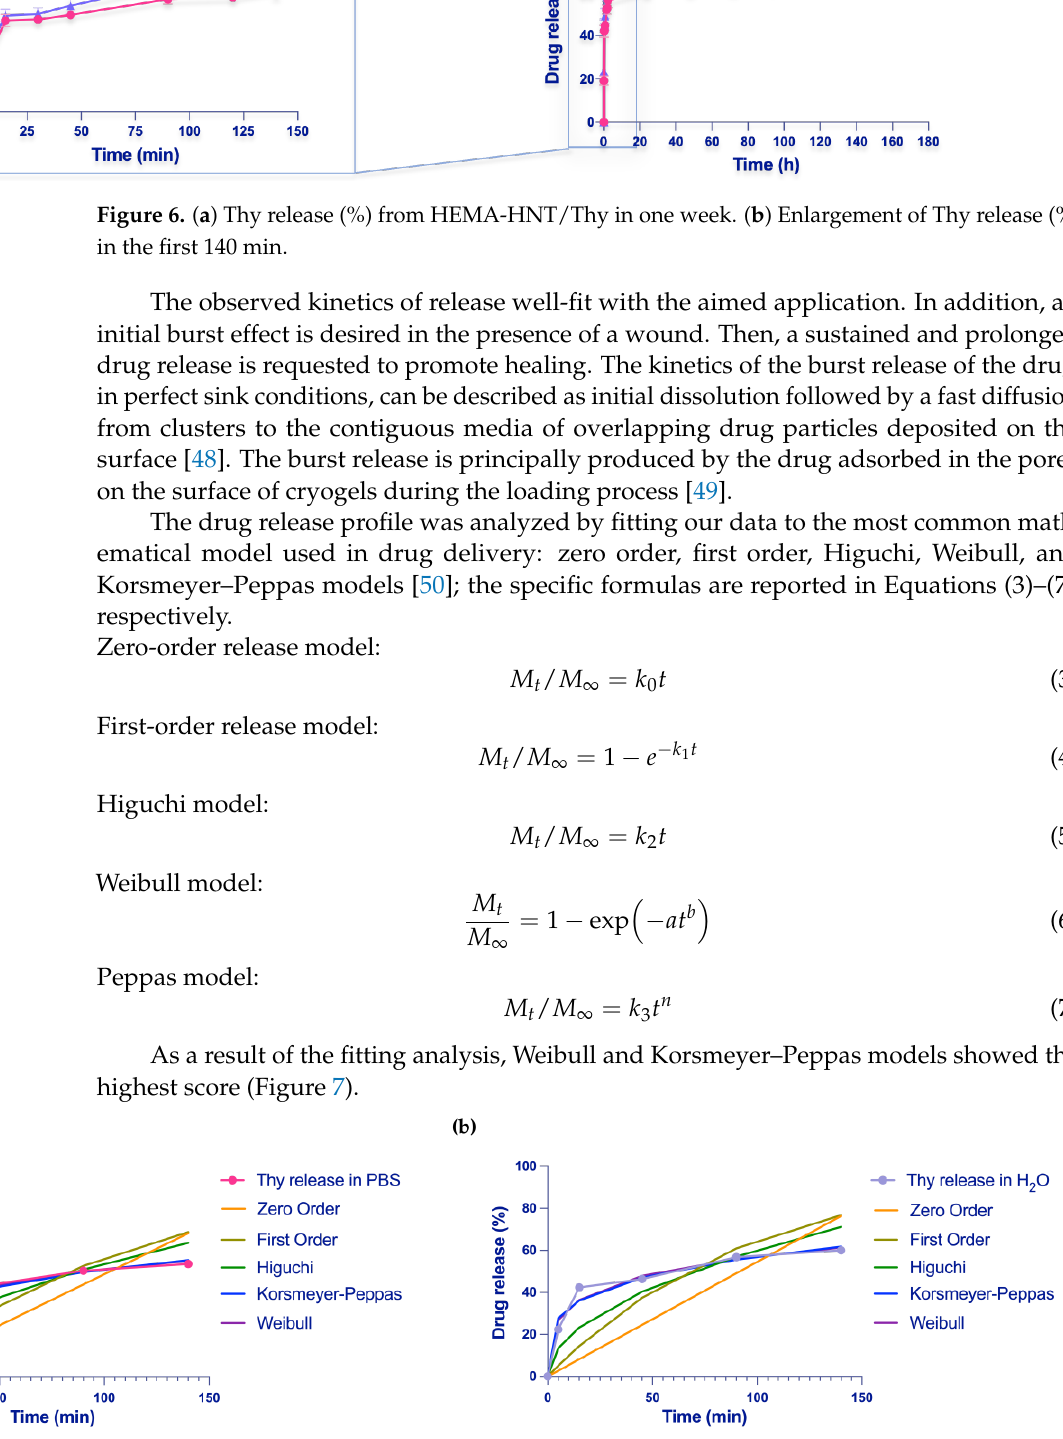
Figure 7. Kinetic release fitting for the Thy from HEMA-HNT/Thy cryogel in ( a ) saline buffer and ( b ) water.